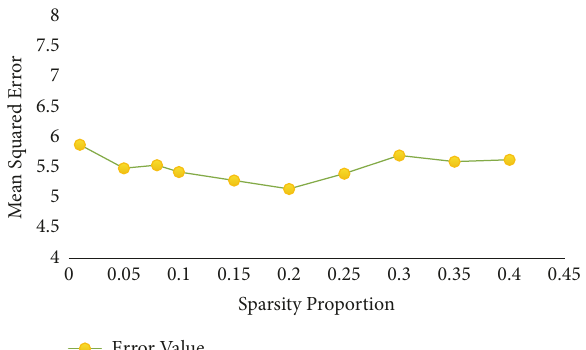
Figure 4: The effect of the number of hidden nodes in the first autoencoder on the reconstruction error.